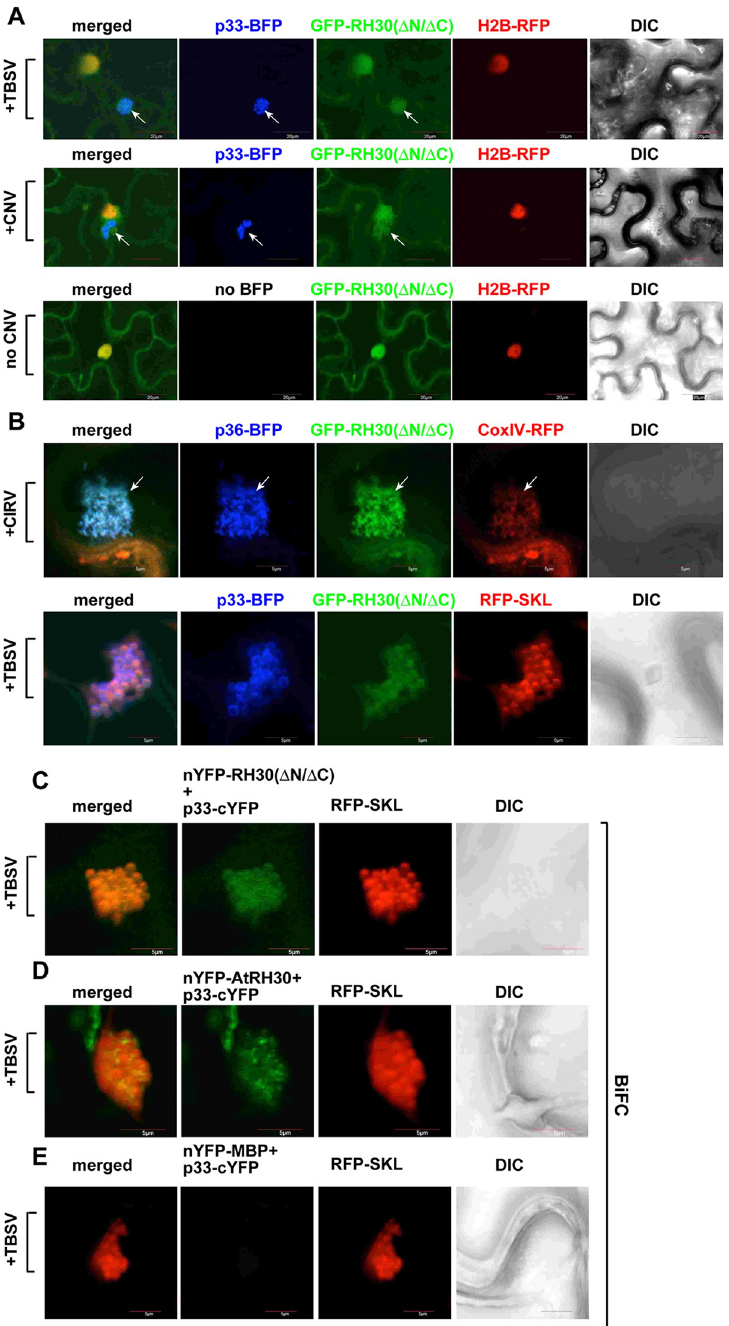
Fig 2. Confocal microscopy shows the retargeting of the nuclear/cytosolic RH30 Δ N/ Δ C helicase into the large replication compartment in whole plants infected with a tombusvirus. (A) Confocal microscopy images show that most of RH30 Δ N/ Δ C helicase is re-targeted into the replication compartment marked by the BFP-tagged p33 replication protein (pointed by arrows) in N . benthamiana plants infected with either TBSV or CNV. Bottom panel: distribution of RH30 Δ N/ Δ C helicase in the absence of viral components. The nucleus is marked by a histone protein (transgenic plants expressing nucleus marker RFP-H2B). Scale bars represent 20 μ m. (B) Confocal microscopy images show that the re-targeted GFP-RH30 Δ N/ Δ C helicase is present in the VRO, marked by the CIRV p36-BFP replication protein and CoxIV-RFP mitochondrial marker. Arrows point at the large VRO. Expression of the above proteins from the 35S promoter was done after co-agroinfiltration into N . benthamiana leaves. The agro-infiltrated leaves were collected